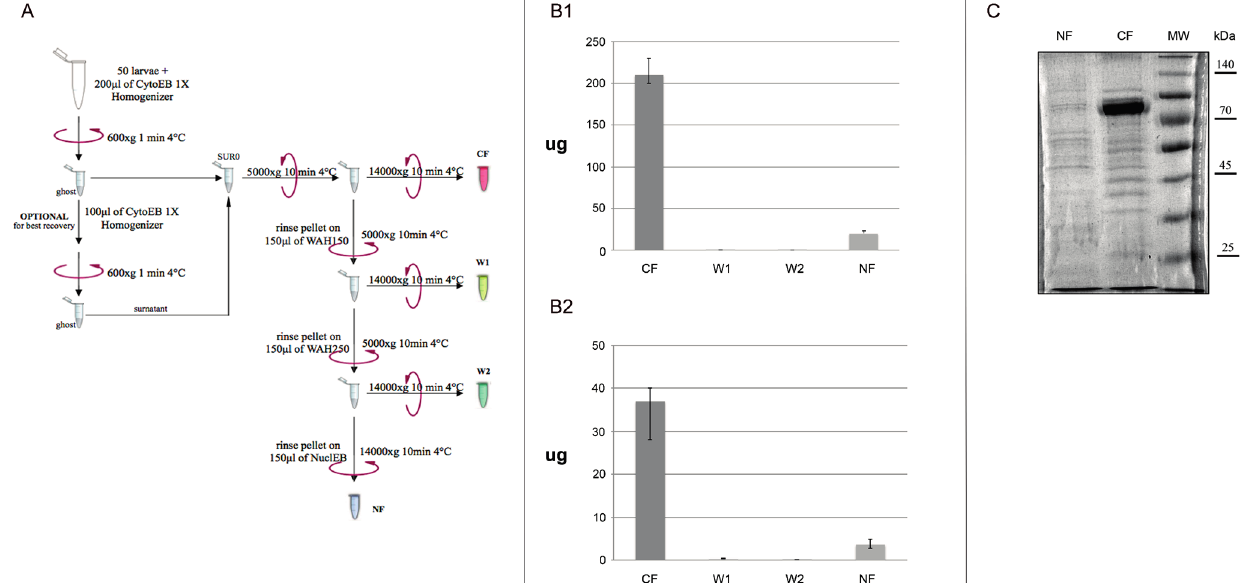
Figure 1. Workflow’s chart. ( A ) Graphic representation of our protocol; All four fractions extracted are assayed in a Bradford reaction to estimate the total yield of proteins extracted for each extraction in Whole Larvae (WL) ( B1 ) and in tissues ( B2 ). CF: Cytoplasmic fraction; W1: supernatant obtained after washing with WASH150 solution; W2: supernatant obtained after washing with WASH250 solution; NF: Nuclear fraction. Standard error is obtained from independent mensuration of six different extractions; ( C ) 3 μ g of NF and CF samples extracted from WL are loaded in 10% acrylamide gel to monitor fractioning of the protein extraction